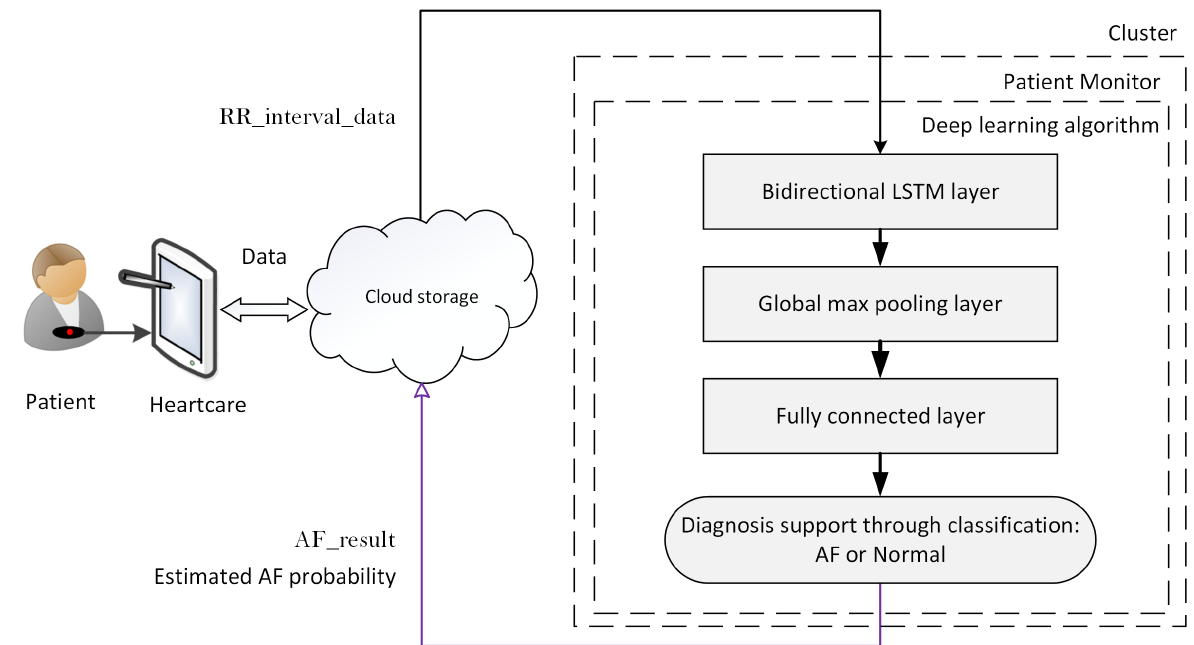
Figure 5. Flowchart of the classification